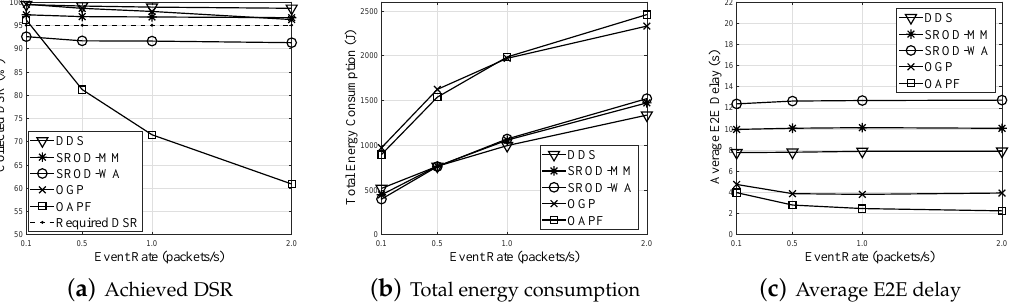
Figure 6. Effects of event rate on the achieved DSR, total energy consumption in the network, and average E2E delay with delay bound θ = 30 s and required DSR γ =